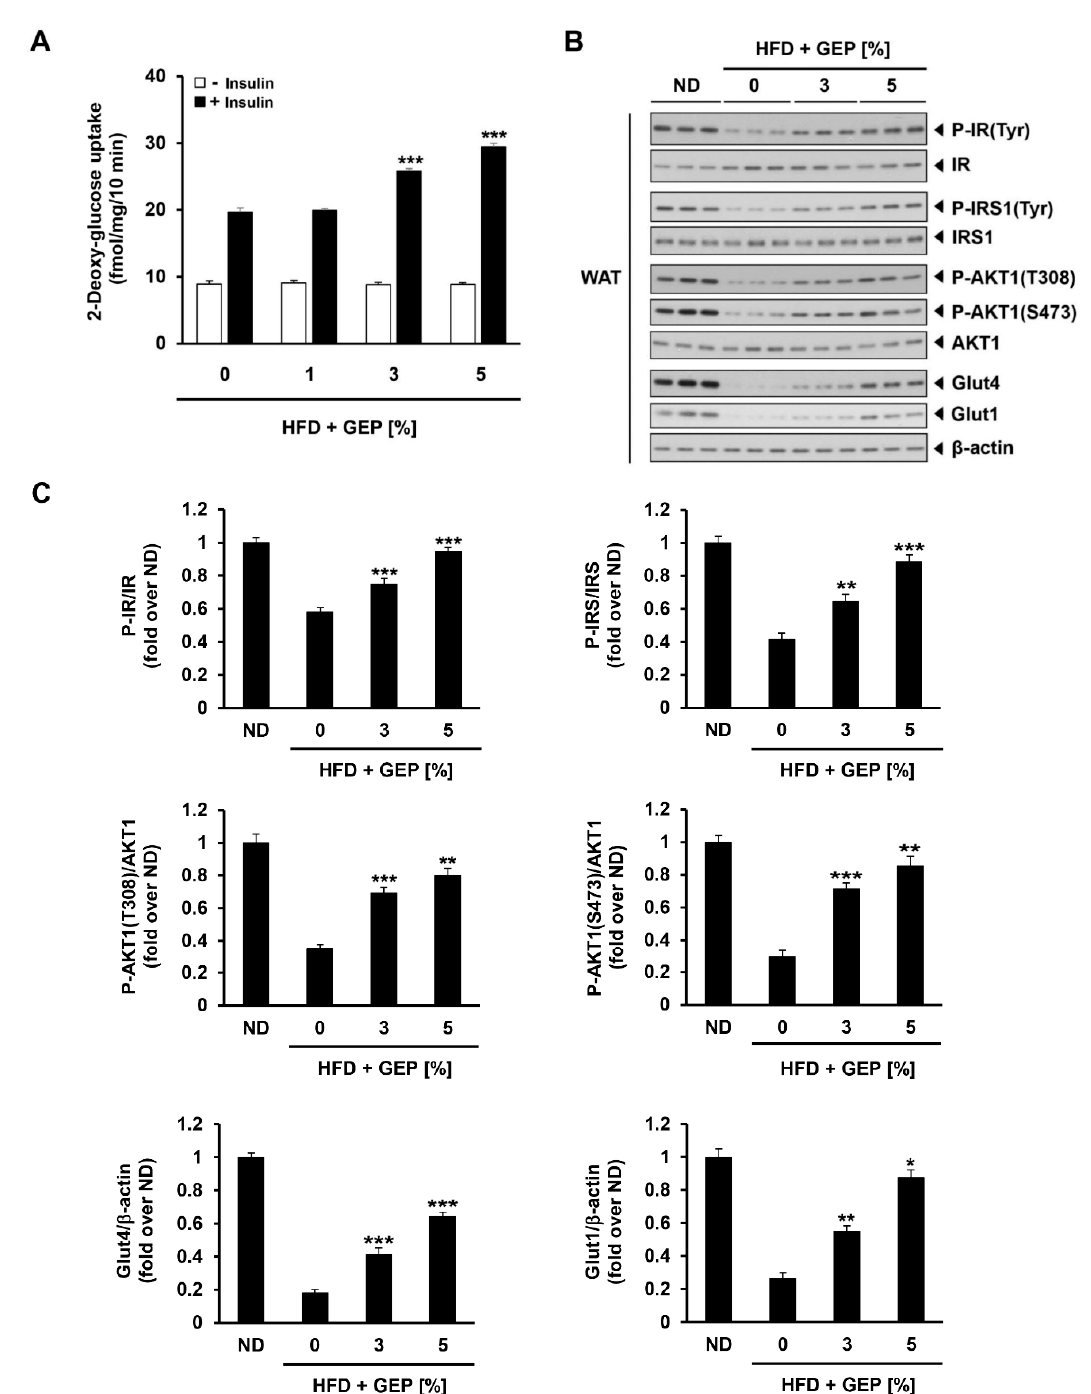
Figure 6. GEP effect on glucose uptake and insulin signaling. ( A ) In vivo 2-deoxy-glucose uptake in WAT treated with and without human insulin (10 mU/mL). ( B ) Western blot analysis of proteins related to insulin signaling in the presence of human insulin (10 mU/mL). ( C ) The phosphorylation ratio of IR, IRS, and AKT1, and the expression of Glut4 and Glut1 compared to β -actin, presented in folds over ND. Data represent the mean ± SD of six to seven individual mice. Significant differences vs. the HFD group (control) were determined by one-way ANOVA; * p < 0.1, ** p < 0.01, *** p < 0.001. HFD: high-fat diet group; GEP: Ganoderma lucidum extract powder. β -actin was used as a relative density control.